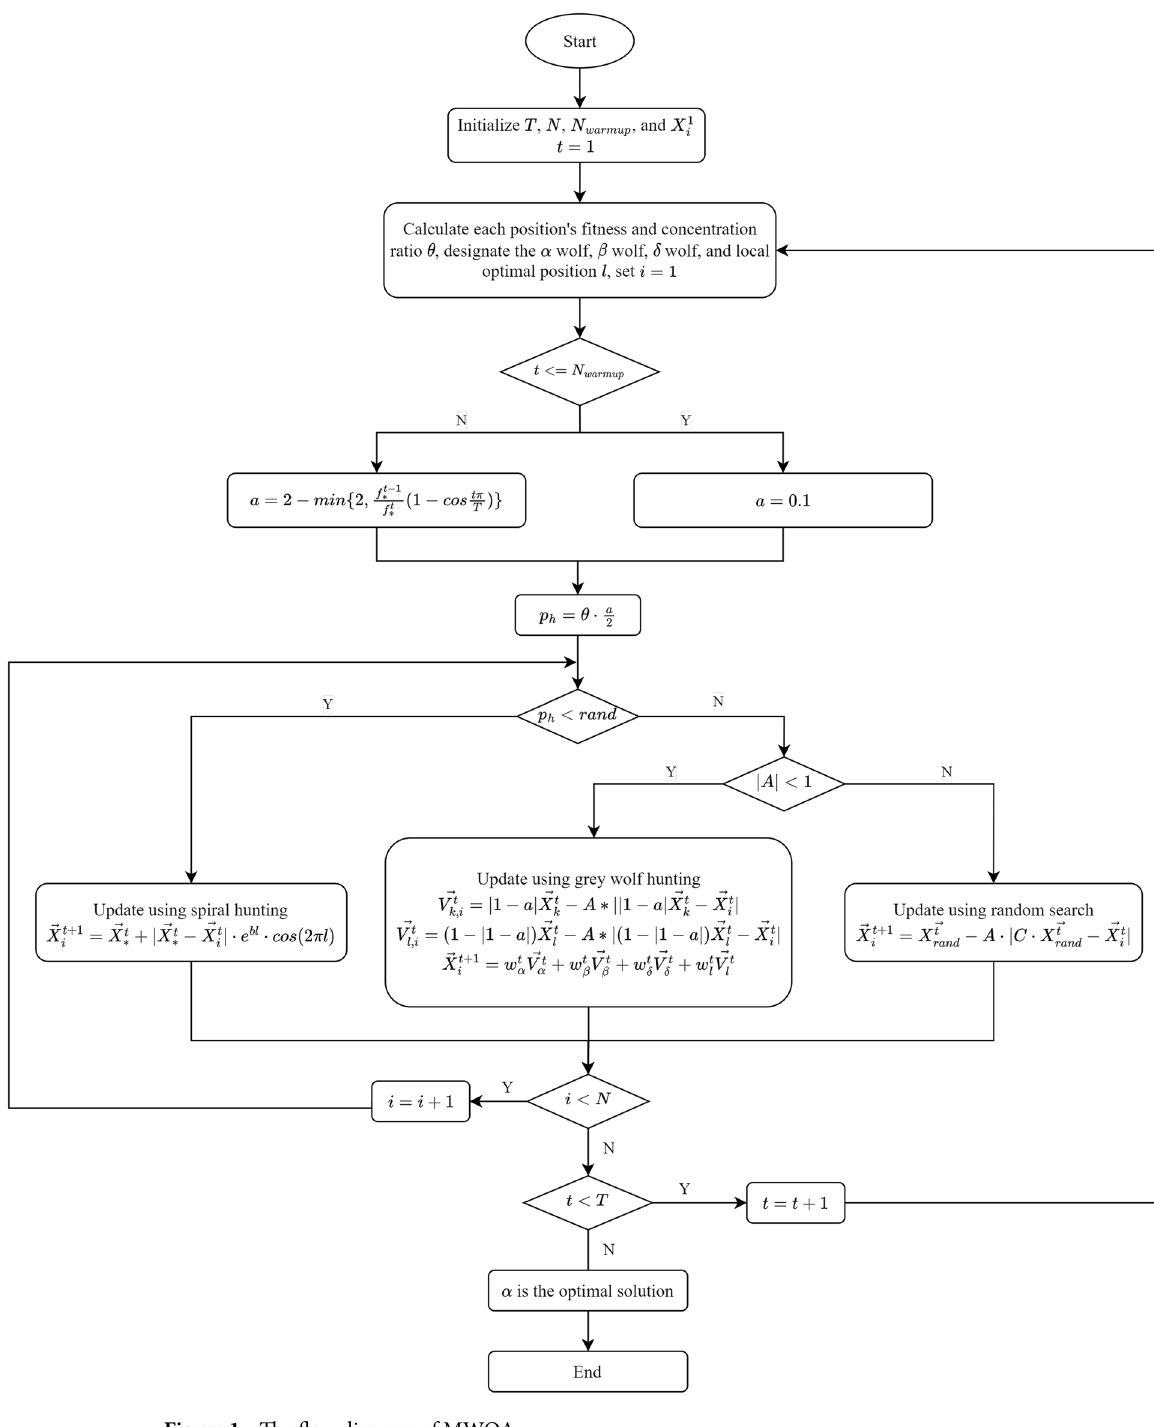
Figure 1. The flow diagram of